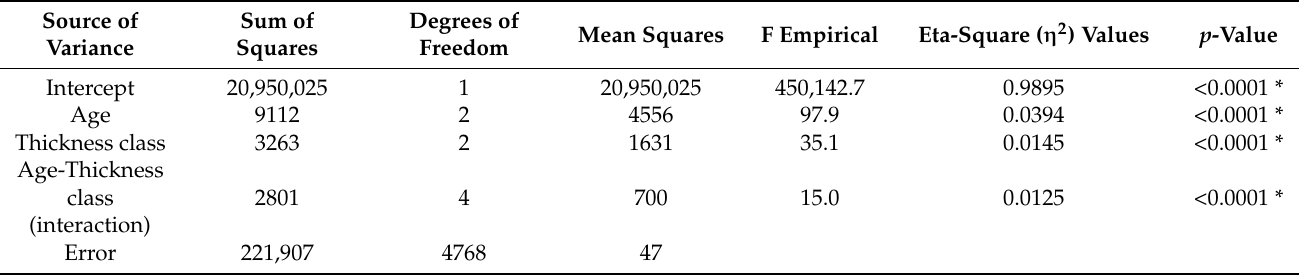
Table 3. Effect on wood hardness of tree age and thickness class and interaction between these factors (two-way analysis of variance).